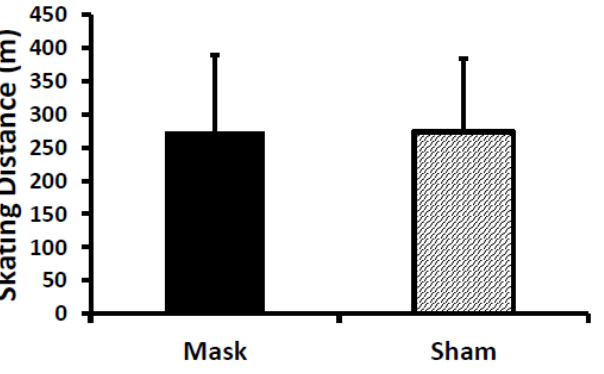
Figure 5. Skating distance during the maximal Yo-Yo Intermittent Recovery on-ice test. There was no difference between the mask and sham conditions. Values are means and error bars are SD.